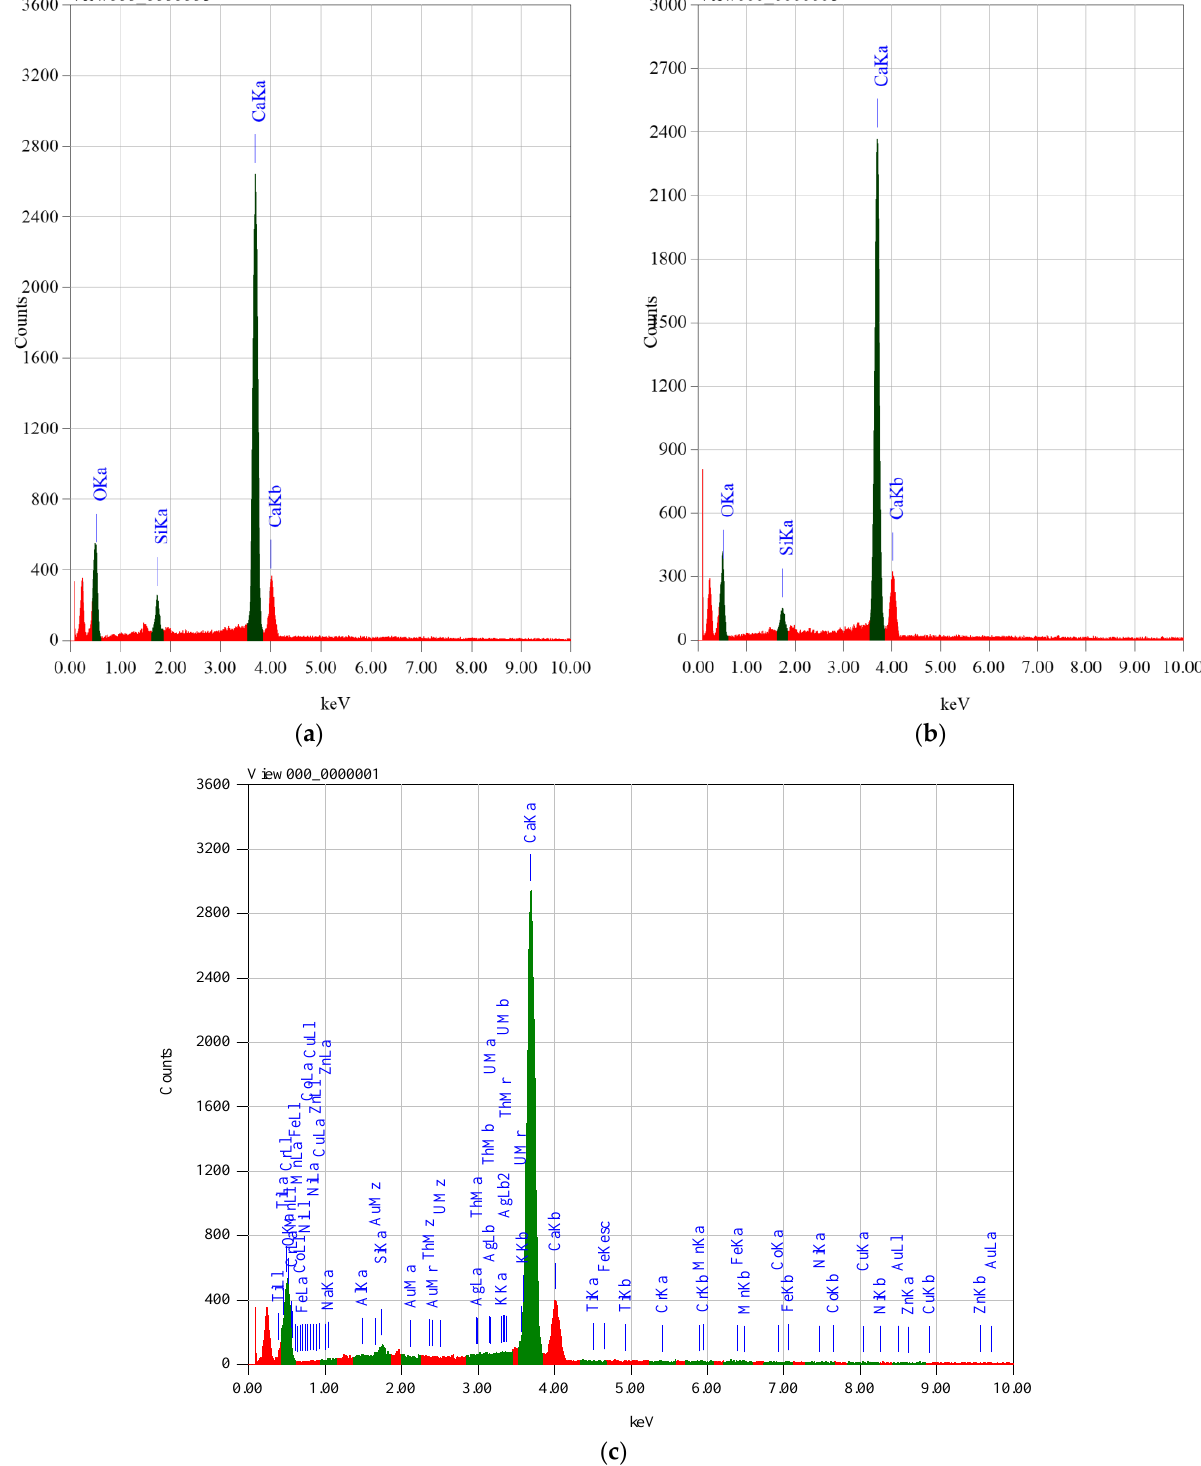
Figure 1. The energy dispersive spectrometer (EDS) spectra of marble: ( a ) Breshia, ( b ) Galala, ( c ) Trista.